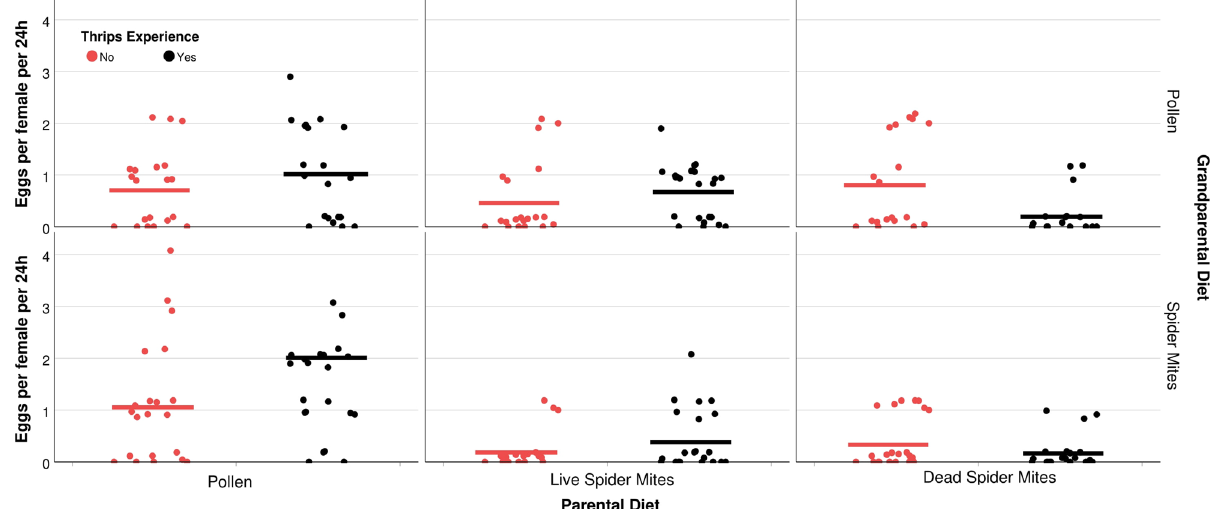
Fig. 6 Oviposition rate. Number of eggs produced within 24 h (dots represent individual experimental animals; short horizontal bars represent the means) by mated A. swirskii females, kept singly inside acrylic cages and presented three 1st instar thrips, F. occidentalis . Predatory mite females had experienced thrips early in life or not ( + or − ) and were the progeny of parents fed Typha pollen (P), life spider mites (L), or dead spider mites (D), and grandparents fed Typha pollen (P) or live spider mites (L). The numbers of replicates ( n ; independent experimental animals) within treatments (sequence in treatment acronyms is grandparental diet, parental diet, early life experience by progeny) are 21 (LP + ), 21 (LP − ), 21 (LL + ), 18 (LL − ), 20 (LD + ), 22 (LD − ), 20 (PP + ), 20 (PP − ), 23 (PL + ), 20 (PL − ), 16 (PD + ), 19 (PD − ). Grandparental and parental diet, and the pairwise interactions of parental diet with thrips experience and with grandparental diet had signi fi cant effects (GLM, P < 0.05; see Table 1 for complete statistical